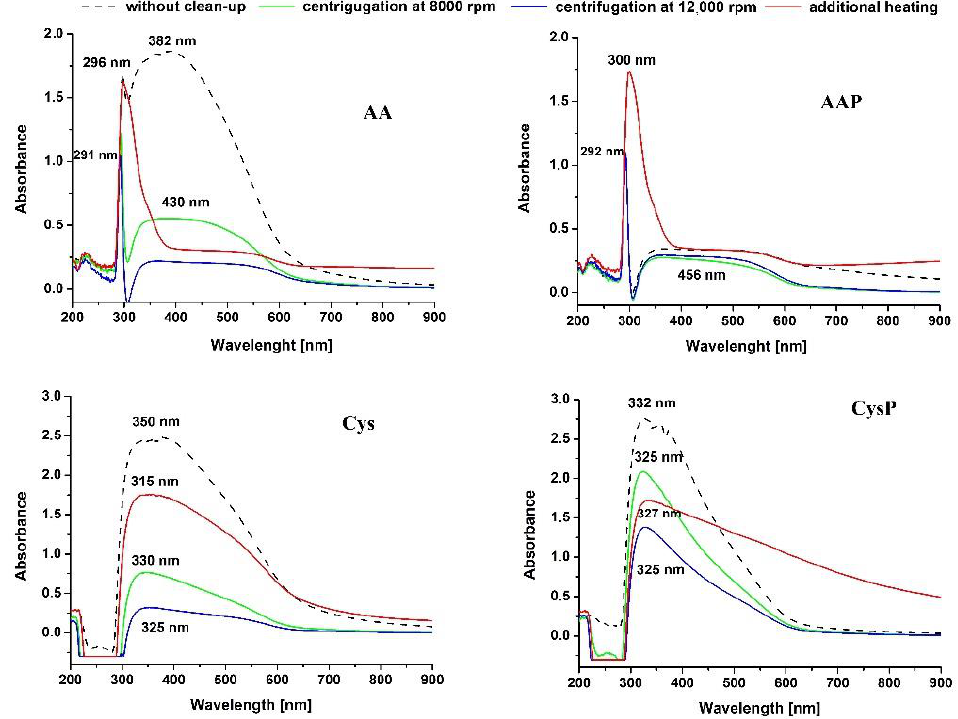
Figure 4. UV–visible spectra of SeNPs after the application of various cleaning Figure 4. UV – visible spectra of SeNPs after the application of various cleaning procedures.